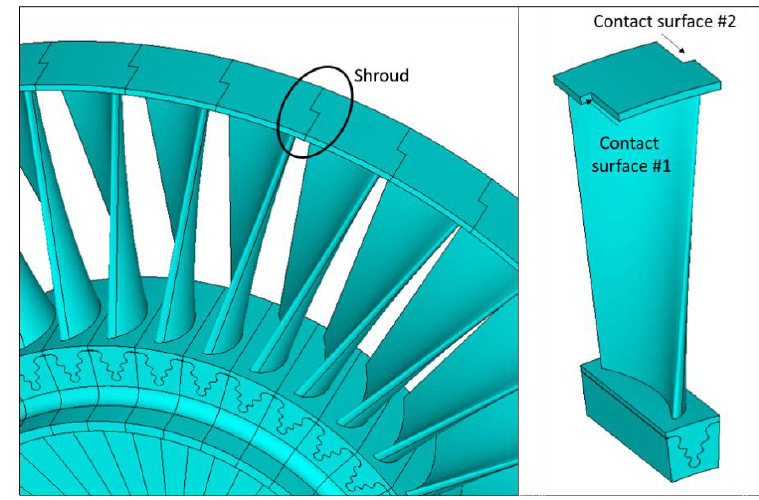
Figure 1. Shrouded blades ( left ) and the shroud contact surfaces ( right ).